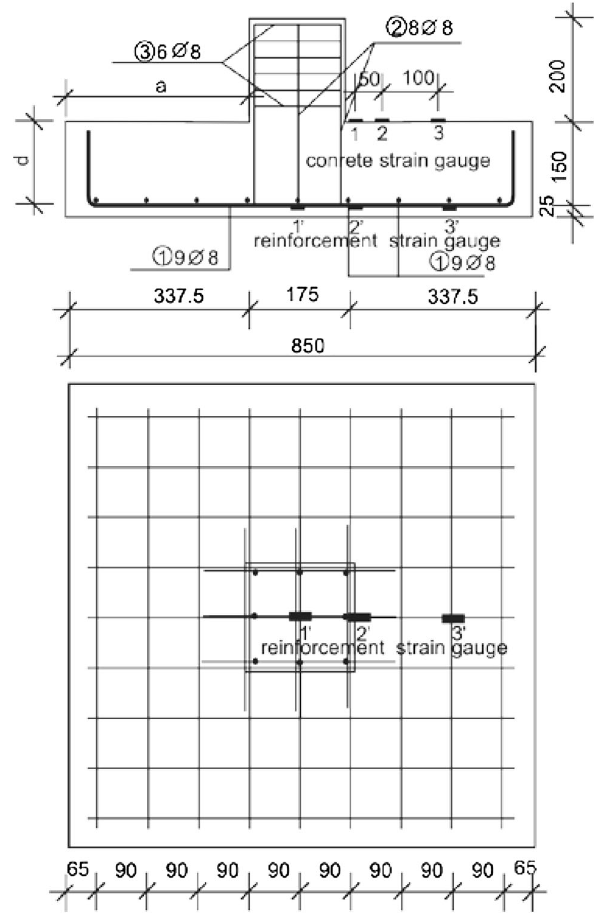
Fig. 8 Sample of a tested footing with dimensions and position of measuring spots for reinforcement and concrete strain gauges.